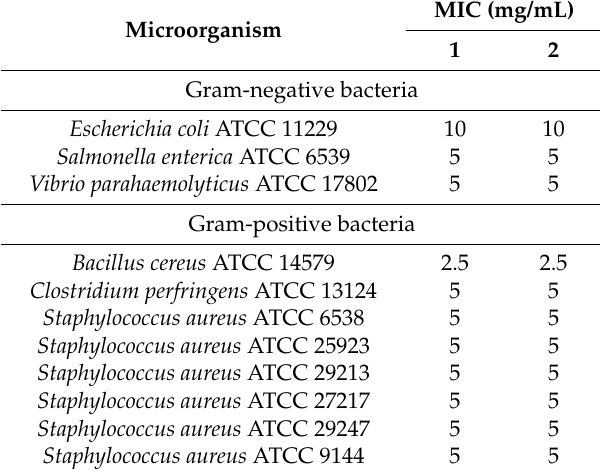
Table 1. The minimum inhibitory concentrations of 3- p - trans -coumaroyl-2-hydroxyquinic acid ( 1 ) and chlorogenic acid ( 2 ) against different microorganisms. MIC: minimum inhibitory concentration.